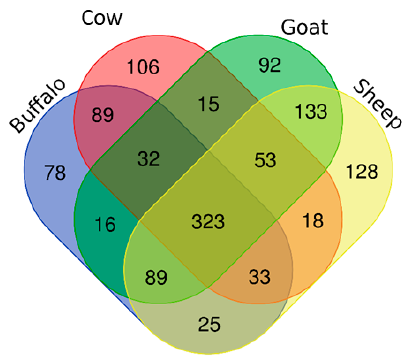
Figure 2. Venn diagram with the distribution of protein groups detected from buffalo, cow, sheep and goat cream samples. Image constructed using the Draw Venn Diagram tool at Bioinformatics & Evolutionary Genomics. Available online: http://bioinformatics.psb.ugent.be/webtools/Venn/ (ac- cessed on 24 April 2020).